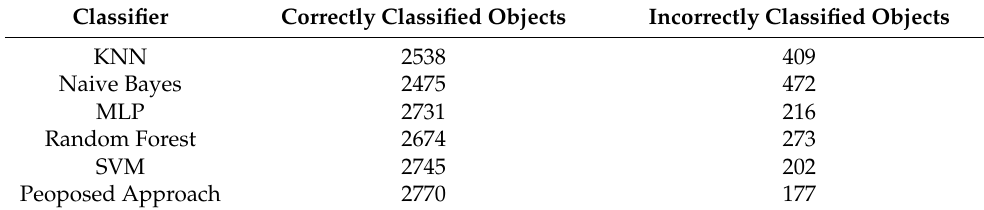
Table 2. Accuracy of Candidates Classifiers.